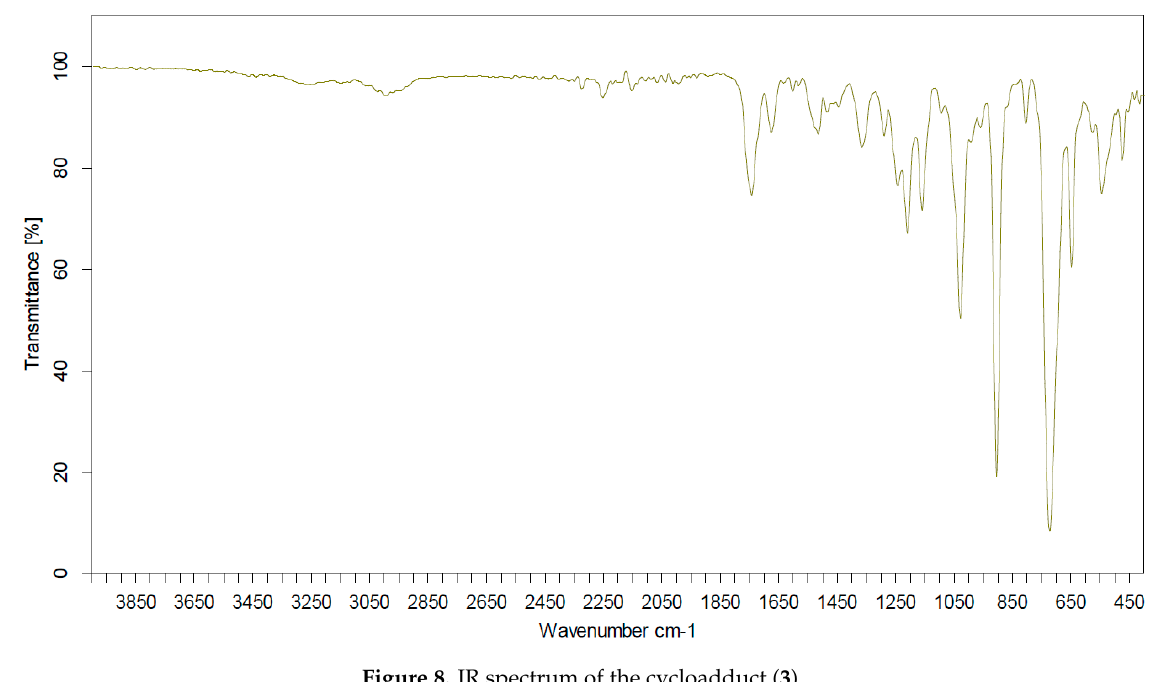
Figure 8 . IR spectrum of the cycloadduct (3).